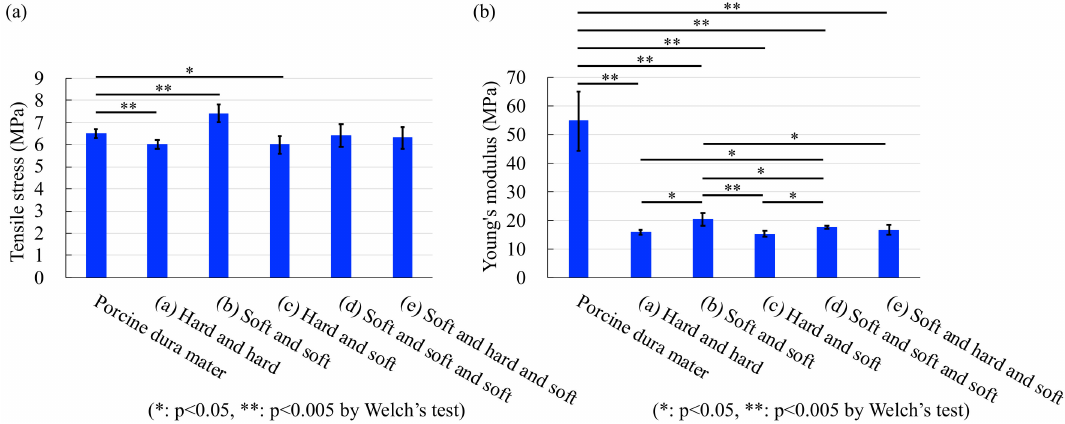
Figure 9. Experimental results of tensile measurements: ( a ) Tensile stress of porcine dura-mater and each dura-mater model; ( b ) Young’s modulus of porcine dura-mater and each dura-mater model.